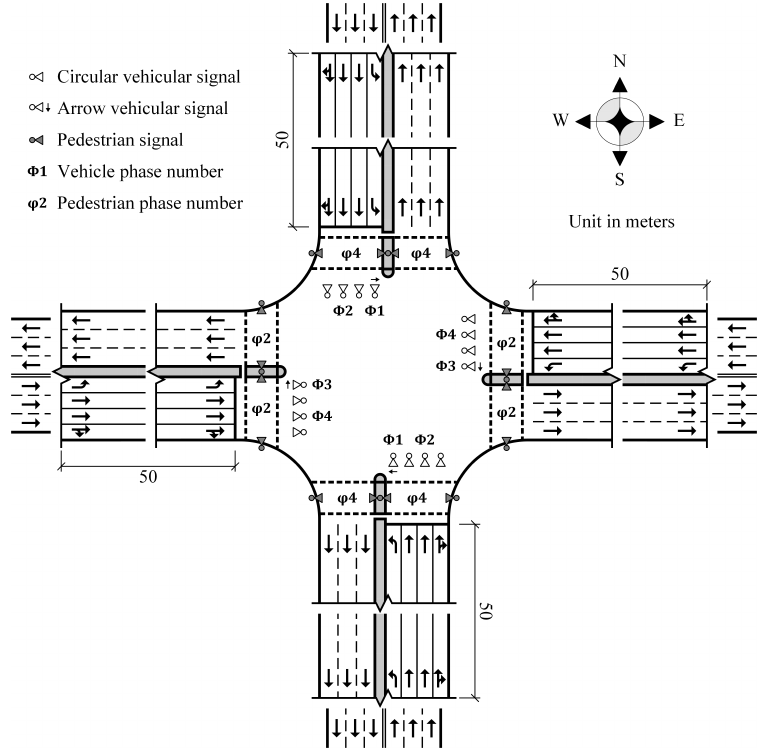
Figure 4. Layout of the virtual